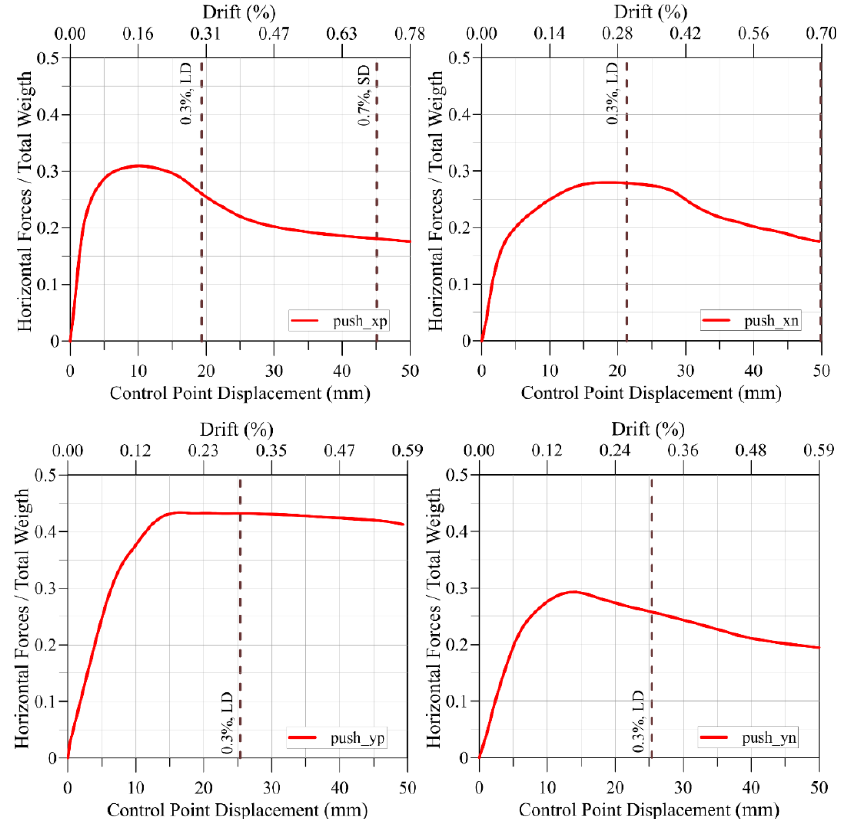
Figure 20. Pushover analysis graphs of the perimeter walls.